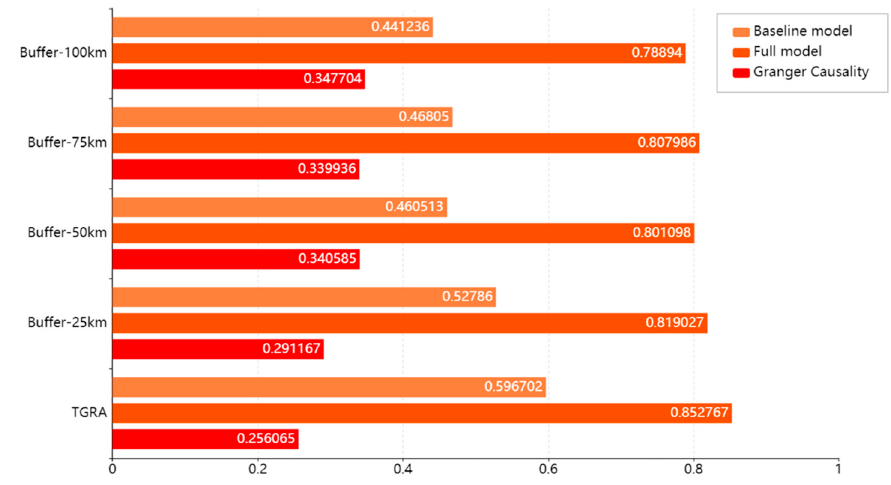
Figure 5. Feedbacks of vegetation dynamics with respect to the cumulative sum of 30 days’ water level.